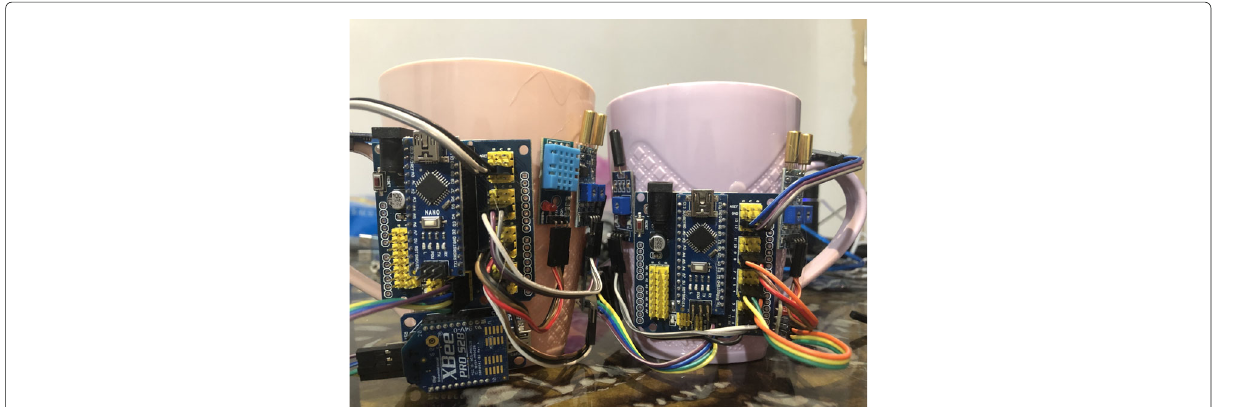
Fig. 5 A deployed cup model of multi-modeling